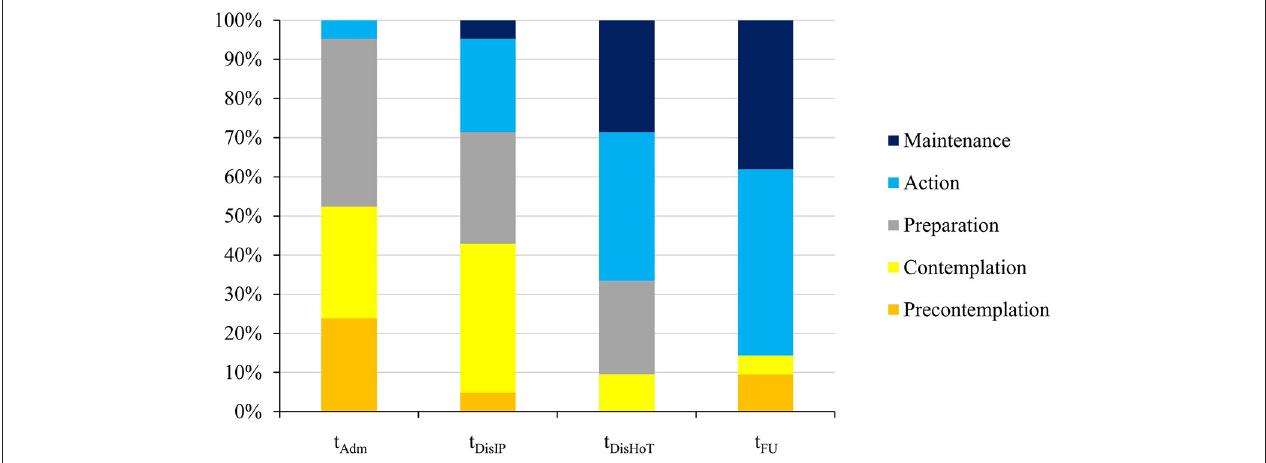
FIGURE 1 | Overview of the distribution of the motivational stages at the different time points according to the ANSOCQ (Anorexia Nervosa Stages of Change Questionnaire). t Adm , admission; t DisIP , discharge from inpatient treatment; t DisHOT , discharge from home treatment; t FU , follow-up.